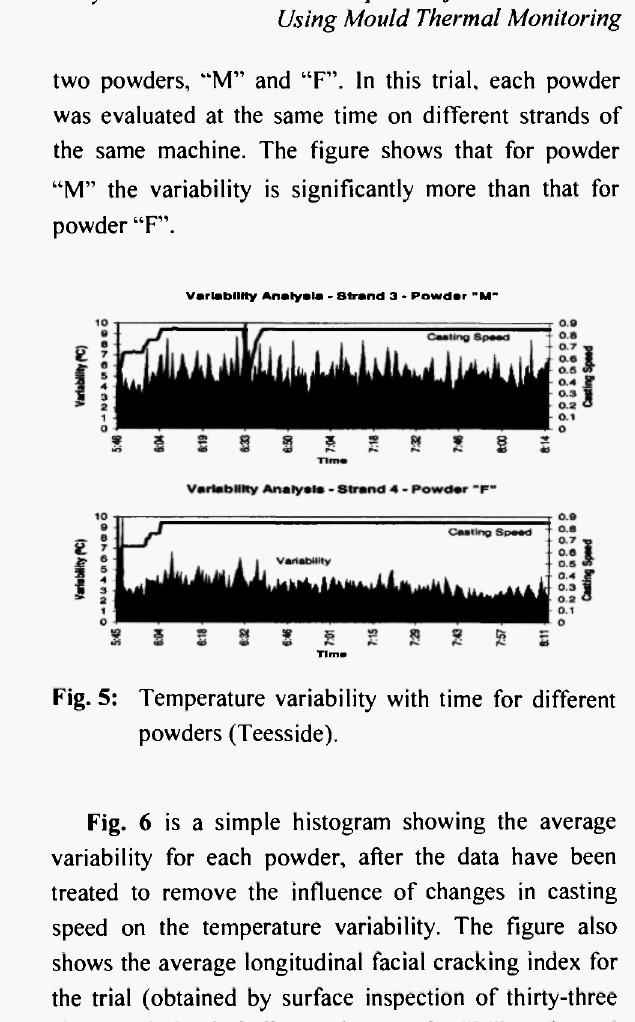
Fig. 5: Temperature variability with time for different powders (Teesside).